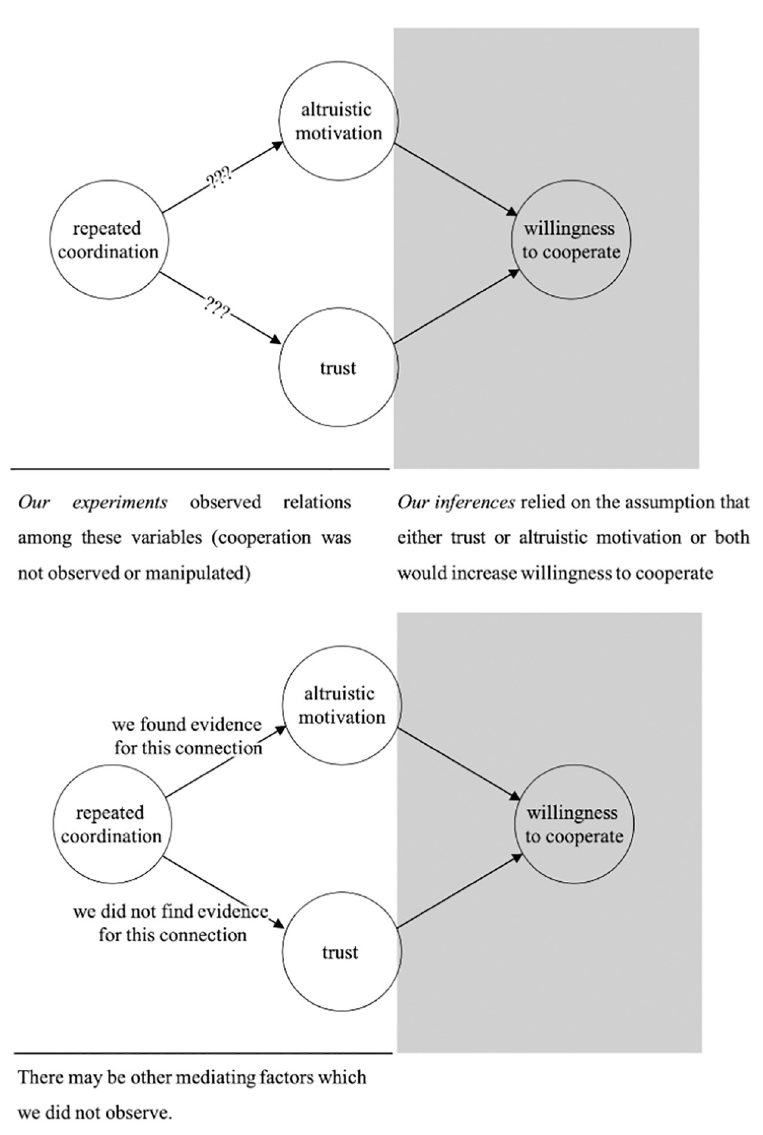
Fig 8. Our research investigated two competing hypotheses for why repeated coordination may boost an agent’s willingness to cooperate with their partner. Our studies relied on the background assumption that either trust or altruistic motivation, or both, would increase agents’ willingness to cooperate with their partners. In each of our two separate studies, we tested a distinct hypothesis and found evidence that repeated coordination boosts altruistic motivation towards one’s partner but found no evidence of an effect of repeated coordination on